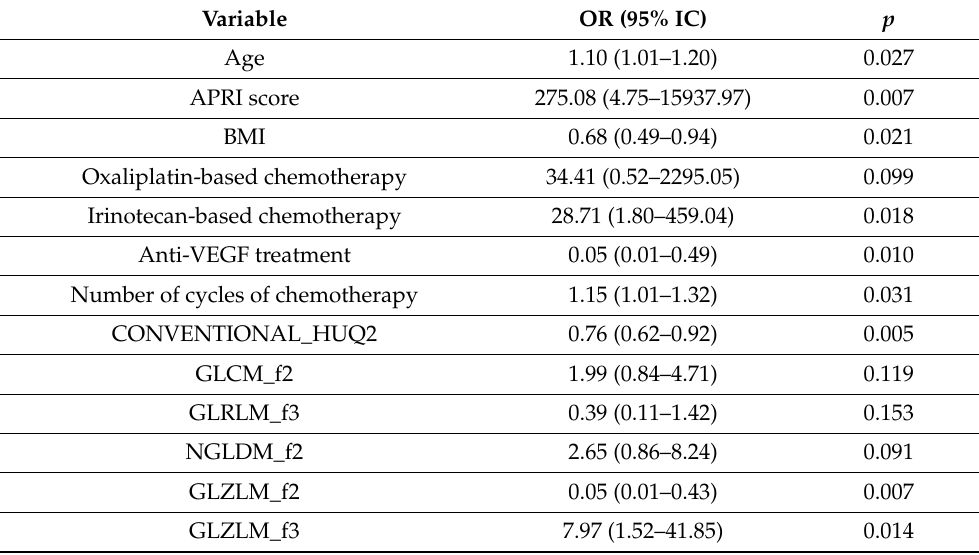
Table 4. Multivariate analysis of predictors of